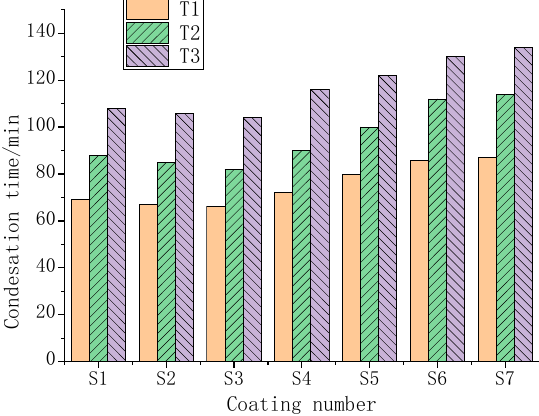
Figure 18. Different coating condensation times under three working conditions at 20 °C.